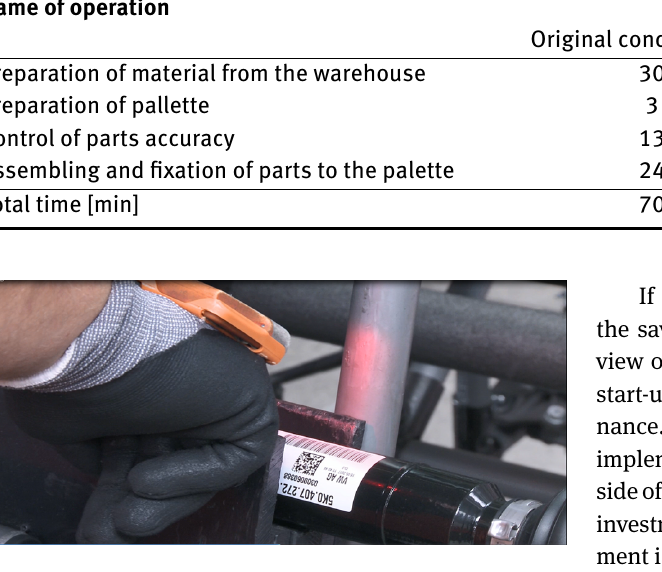
goes out (Figure 7). Workers complete due to text and light helps the whole